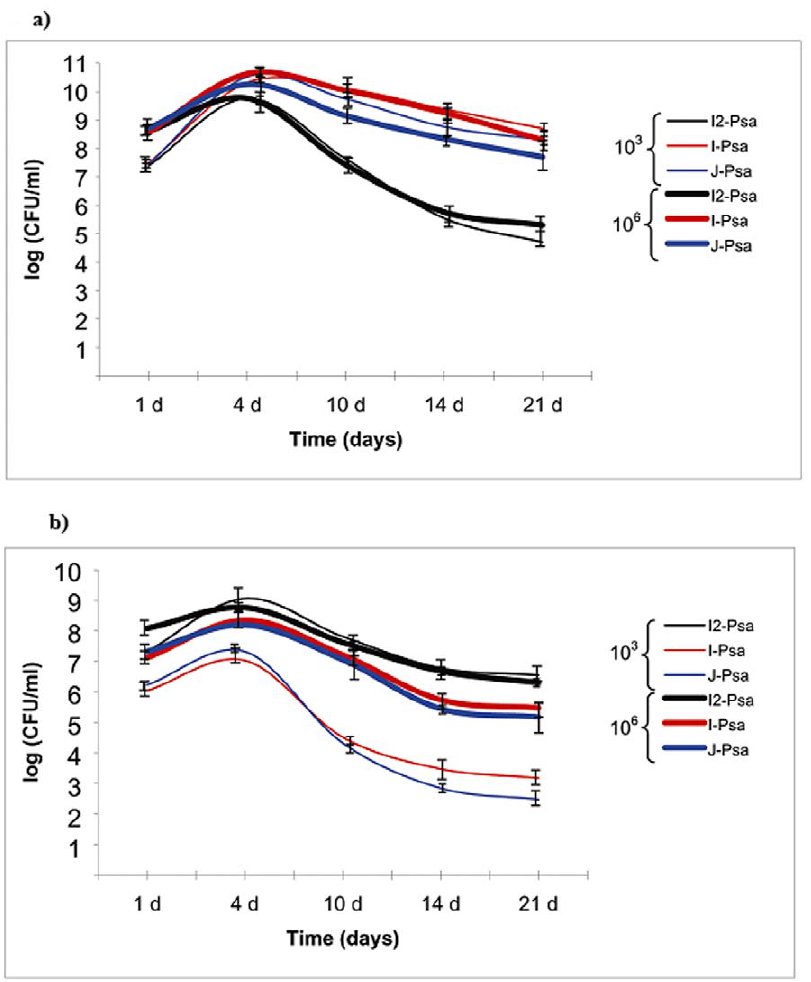
Figure 8. Multiplication trends of Psa strains in Actinidia species. Multiplication in A. deliciosa cv Hayward (a) and in A. chinensis cv Hort16A (b) leaves. Bacteria were inoculated at 1–2 6 10 3 and 1–2 6 10 6 cfu/ml. Data represent the mean log of bacterial cell number and standard deviation (SD) as obtained from eight inoculation sites per each sample.